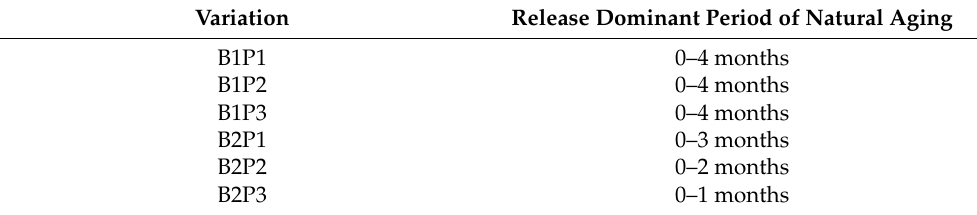
Table 2. Release dominated aging period of aldehydes of pale lager beer from two barley varieties (B1 and B2) and three different malt modification levels (P1 < P2 <